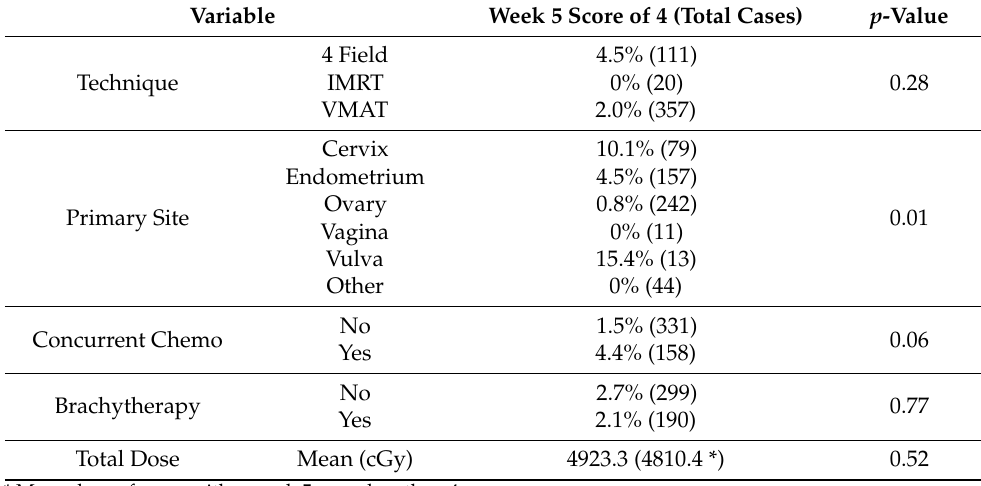
Table 5. Univariate analysis of increased week 2 GI toxicity leading to severe week 5 toxicity (using GI summary question).